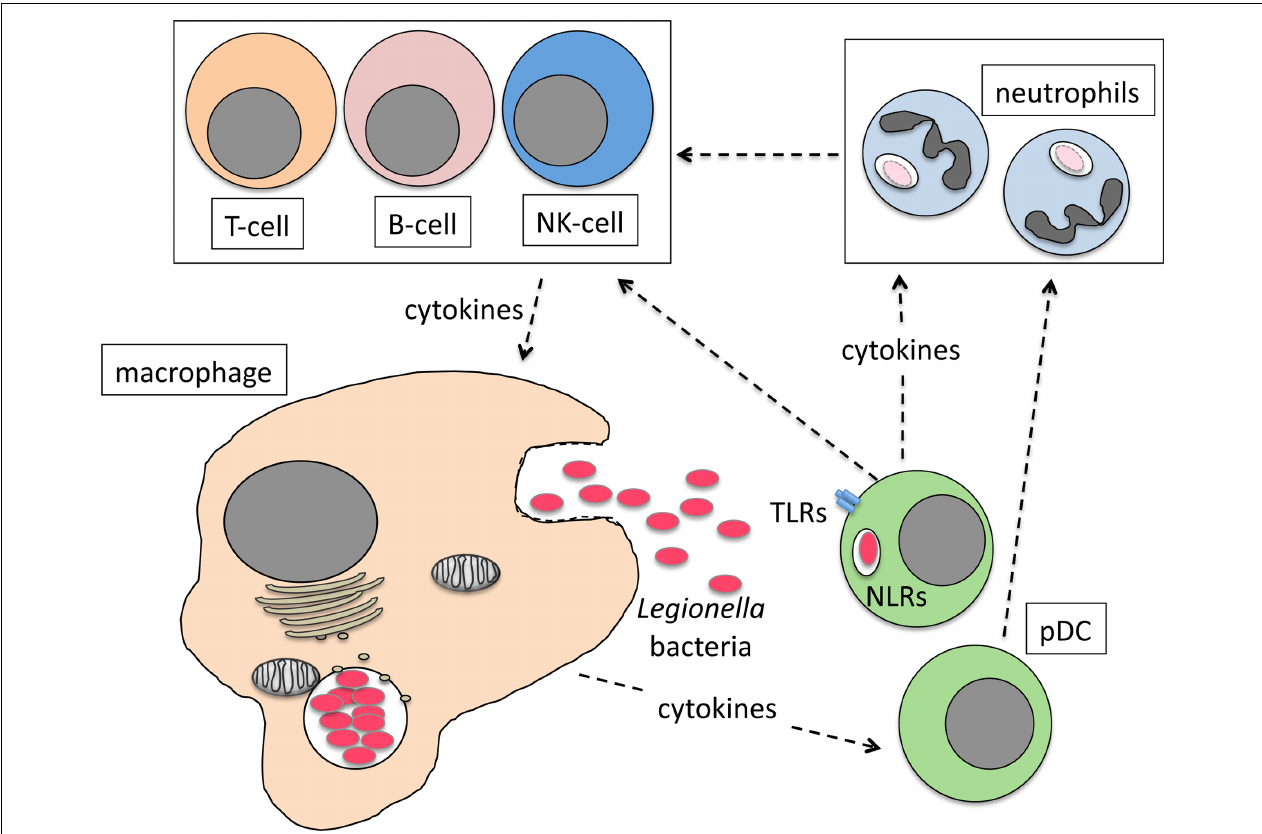
cytokines from infected macrophages stimulate pDC cytokine production that then activates neutrophils, NK cells and macrophages to kill bacteria directly or